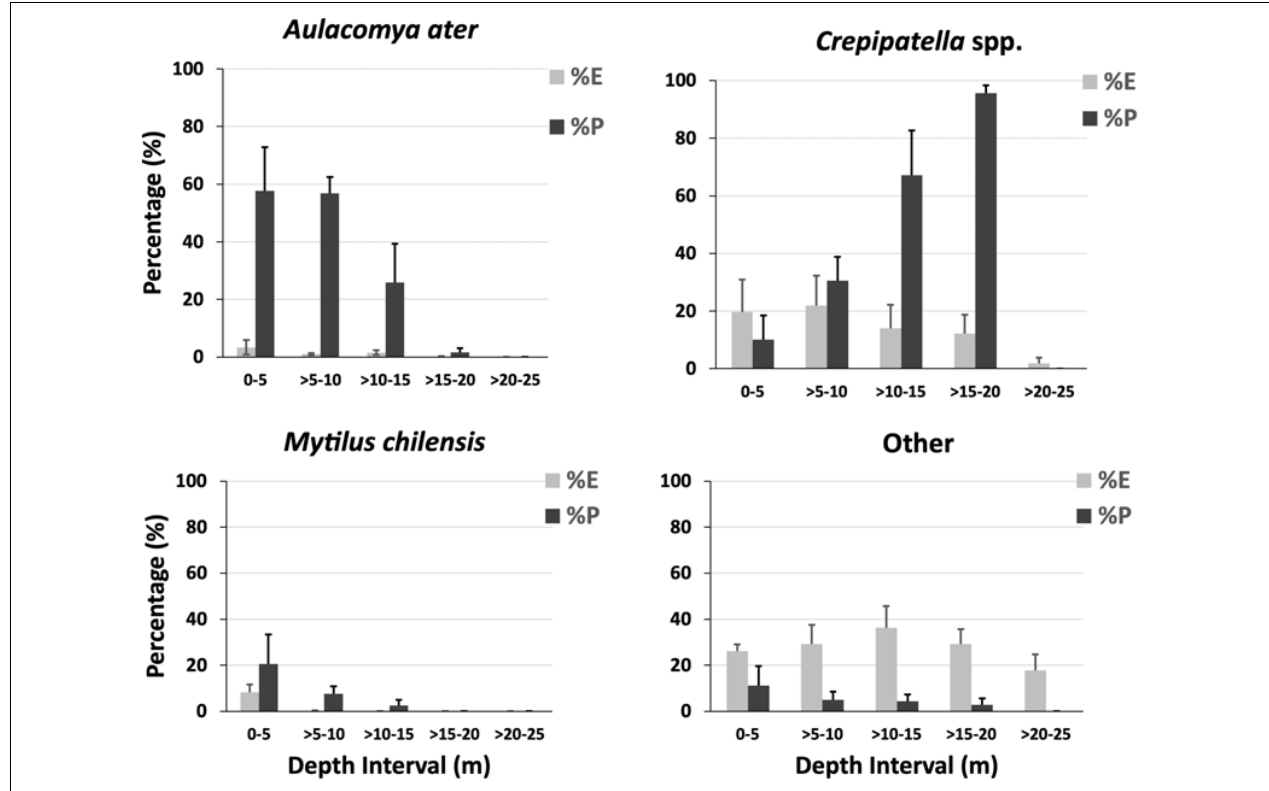
FIGURE 8 | Availability of potential prey (percent cover) in the environment compared to their occurrence in the diet (percentage) of the sea star Cosmasterias lurida in Yerbas Buenas Bay.